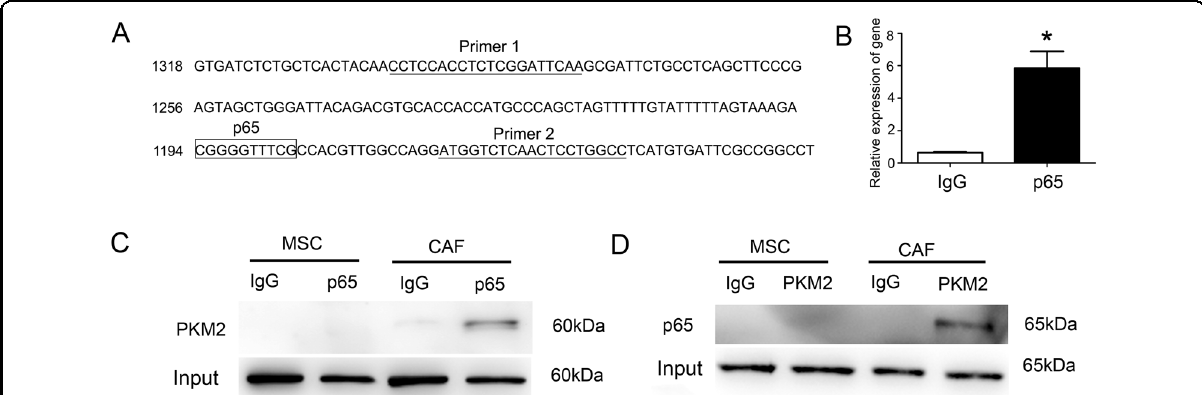
Fig. 5 The interaction between PKM2 and P65. A The PKM2 promoter region had a binding box of P65. B Quantitative PCR analysis detected the chromatin – protein complex captured by CHIP P65 antibody containing the PKM2 promoter region sequence. * P < 0.05. C Western blotting analysis detected the whole-cell lysate protein captured by Co-IP P65 antibody containing PKM2 protein. D Western blotting analysis detected cell lysate protein captured by Co-IP PKM2 antibody containing P65 protein.